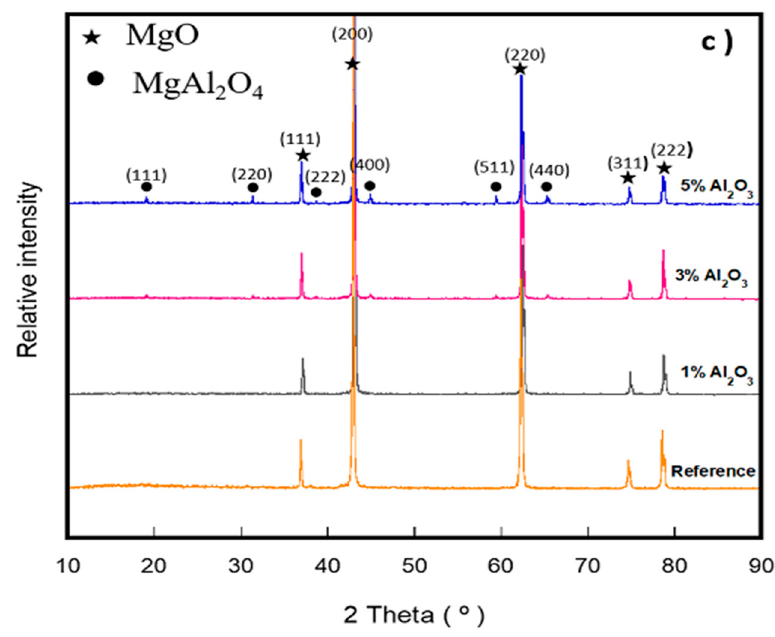
Figure 4. XRD diagrams of the samples containing different levels of α -Al 2 O 3 nanoparticles at different temperatures: ( a ) 1300 °C, ( b ) 1500 °C, and ( c ) 1600 °C. Table 4. Quantitative phase estimation of crystalline phases by the relative intensity method. wt.% Phase Experimental